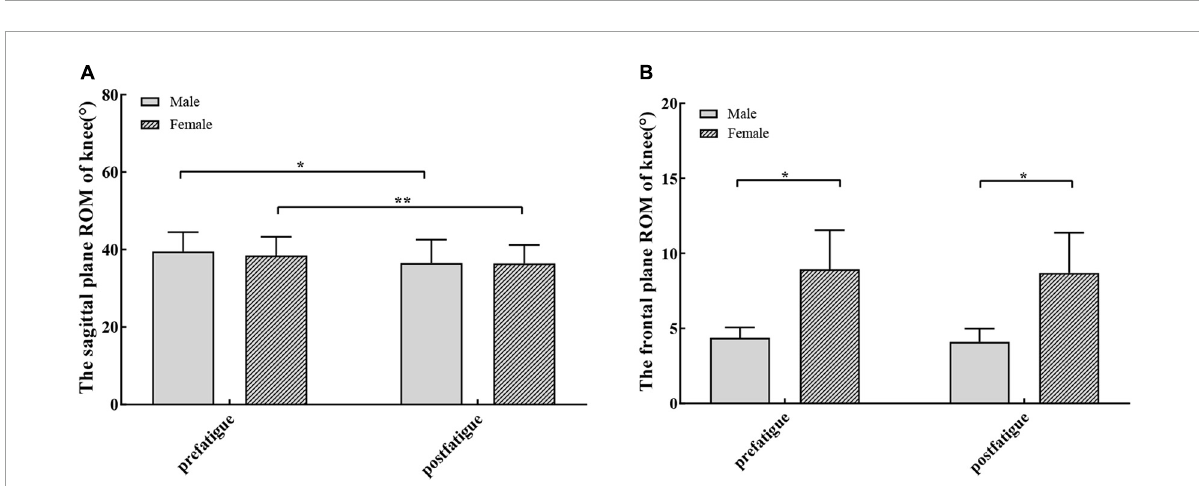
FIGURE6 (A) The knee sagittal plane range of motion (mean and standard error) were significantly different after fatigue in men (dark bars) and women (bar with oblique line). (B) There were no significant differences in frontal plane range of motion (mean and standard error) after fatigue. There were significant differences in the frontal plane range of motion among different sexes before and after fatigue. * P < 0.05, ** P <